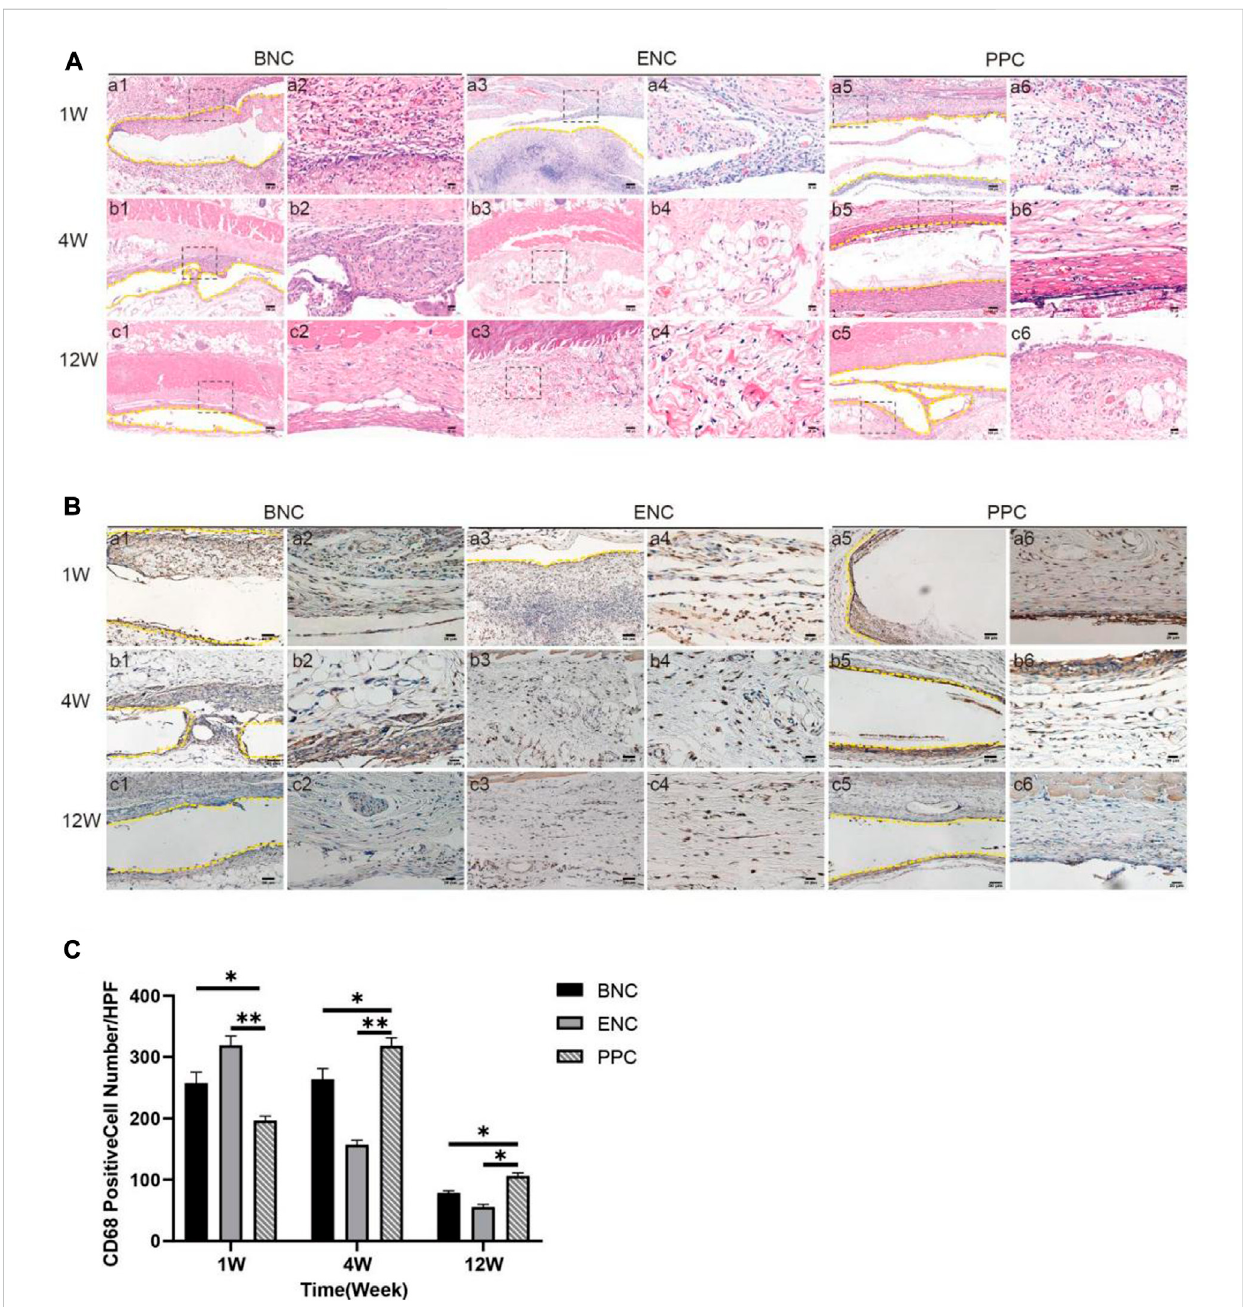
FIGURE 6 Evaluation of the host immune response to the BNC, ENC, and PPC groups. (A) Histological observation of the subcutaneous implantation tests by HE staining. It shows the type and number changing processes of in fl ammatory cells in 1, 4, and 12 weeks after implantation. Images with higher magni fi cation (× 400) (scale bar = 20 μ m) represent the area within the black box in lower magni fi cation images (× 100) (Scale bar = 100 μ m). (B) Histological observation of the subcutaneous implantation tests by immunohistochemical staining. It shows the number and distribution of CD68 macrophagesin the 3 groups during thehealing process. Images with higher magni fi cation (× 400) (scale bar = 20 μ m) represent the positive area of the surrounding tissue at the edge of the material. The yellow dotted line in the images with magni fi cation (× 200) (scale bar = 50 μ m) is the place wherethegraftisplaced. (C) Quanti fi cationofimmunohistochemicalstainingbypositivecellcountingat×400.Dataareexpressedasthemean±SD( n = 5) (* p < 0.05, ** p <